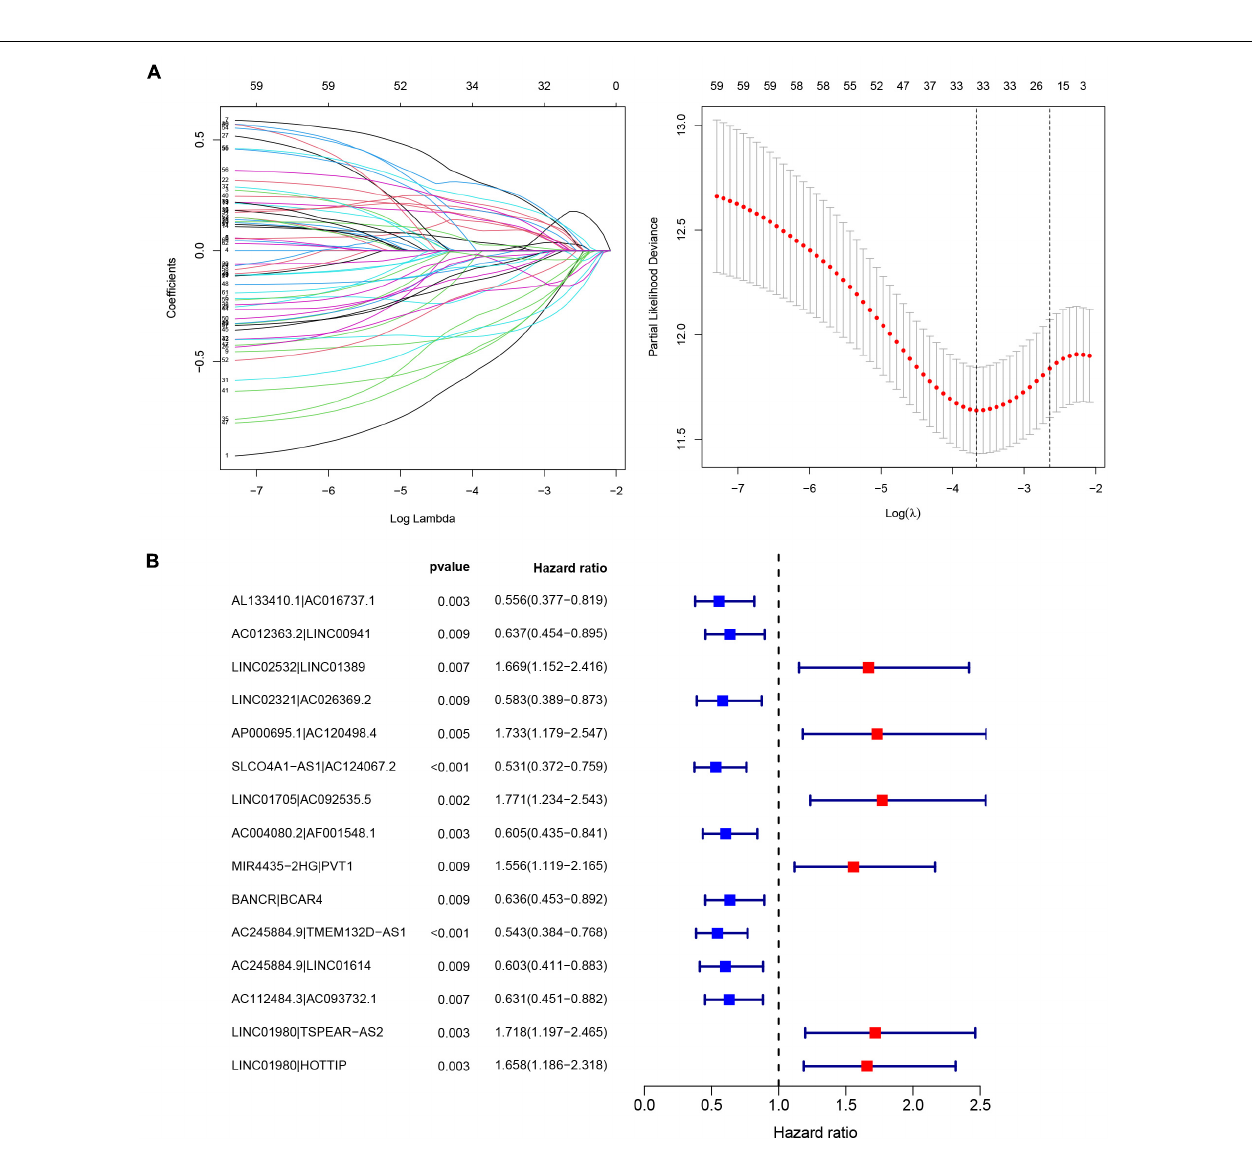
FIGURE 2 | Construction of the prognostic model. (A) Predictor selection by the LASSO and (B) forest plots of the 15 OS-related immune-related long noncoding RNA pairs (IRlncRNAPs) identified by Cox proportional hazard regression, the represented prognostic IRlncRNAPs with hazard ratios > 1 are shown as red dots and the represented prognostic IRlncRNAPs with hazard ratios < 1 are shown as blue